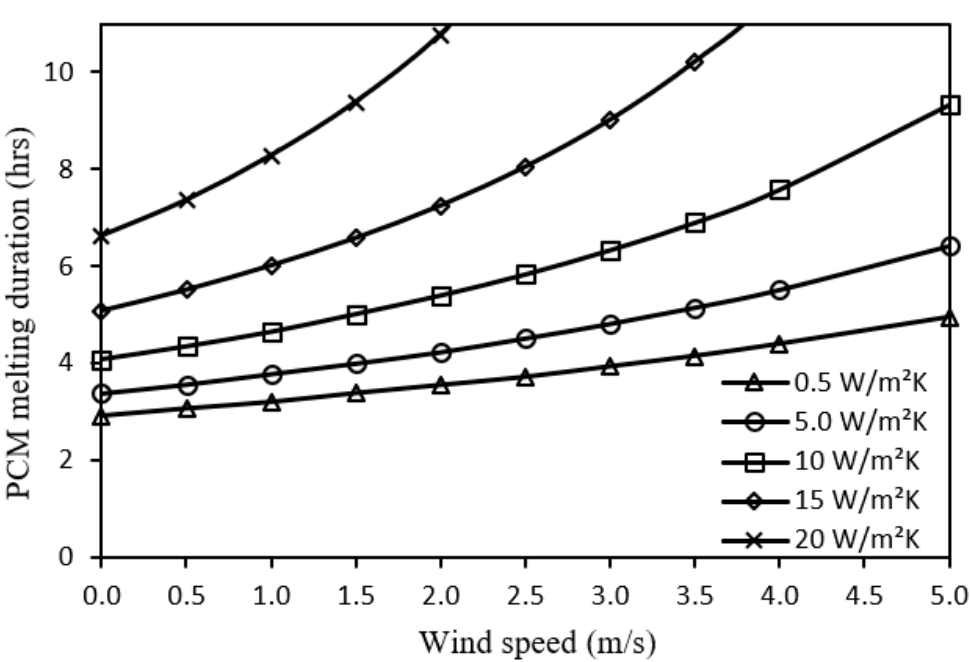
Figure 10. Impact of wind speed on PCM melting duration for different metal foam convective heat transfer coefficients.